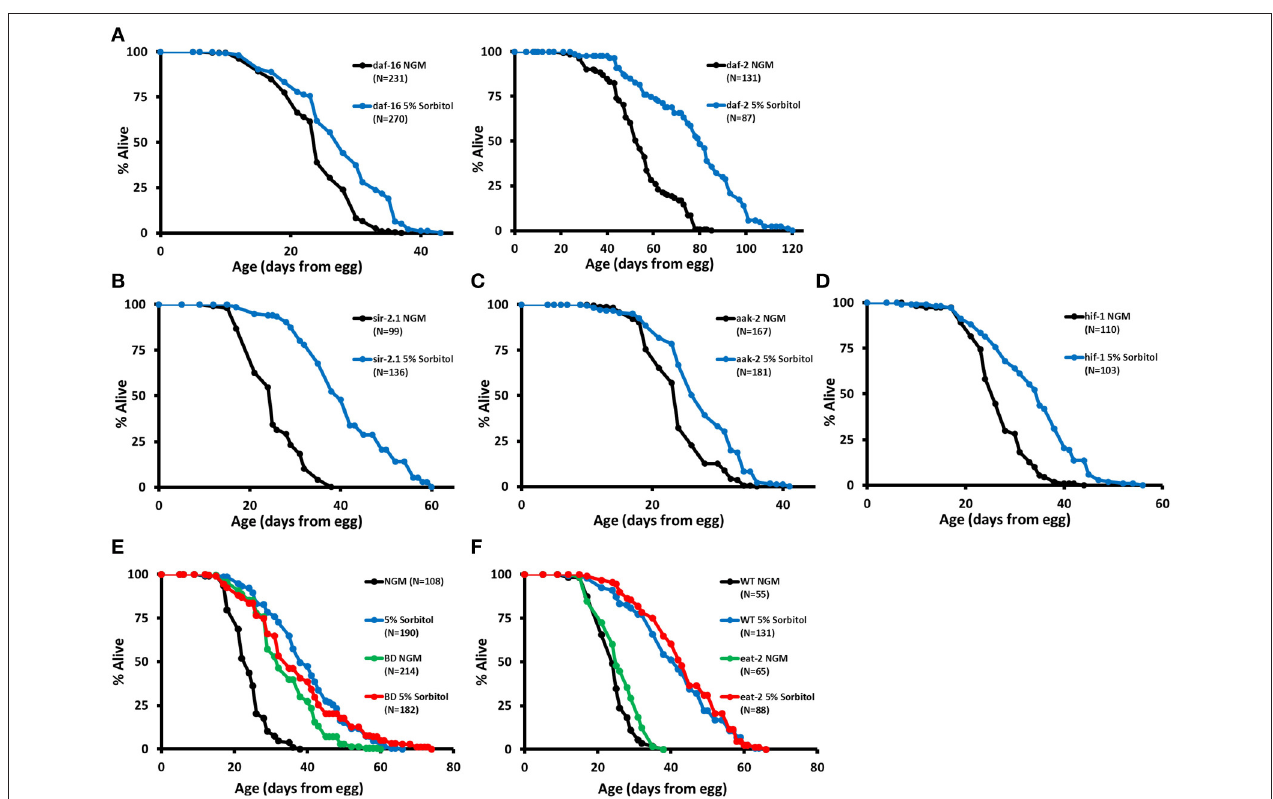
FIGURE 4 | Sorbitol promotes longevity by a mechanism distinct from insulin-like signaling, sir-2.1, AMP kinase, and the hypoxic response. (A) Addition of 5% sorbitol to the NGM extends the lifespan of both daf-16(mu86) and daf-2(e1370) mutants ( p < 0.001 , t -test). Addition of 5% sorbitol to the NGM is also sufficient to extend lifespan in (B) sir-2.1(ok434) null animals, (C) aak-2(ok524) null animals, and (D) hif-1(ia04) null animals ( p < 0.001 in each case, t -test). (E) Dietary restriction by bacterial deprivation (BD) or (F) mutation of eat-2 fails to further extend the lifespan of animals grown on NGM supplemented with 5% sorbitol ( p = 0.21 , t